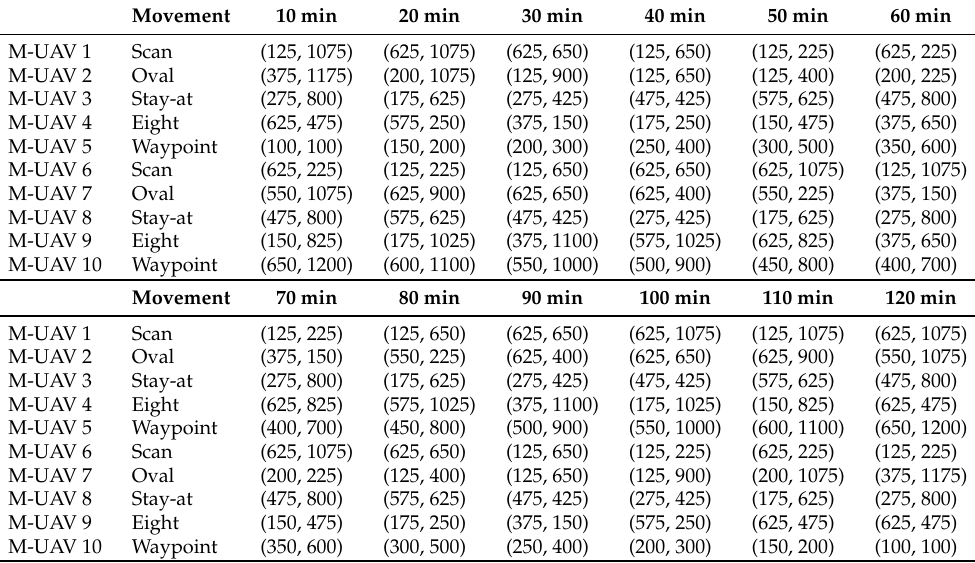
Table 2. Trajectory of moving unmanned aerial vehicles (M-UAVs) every 10